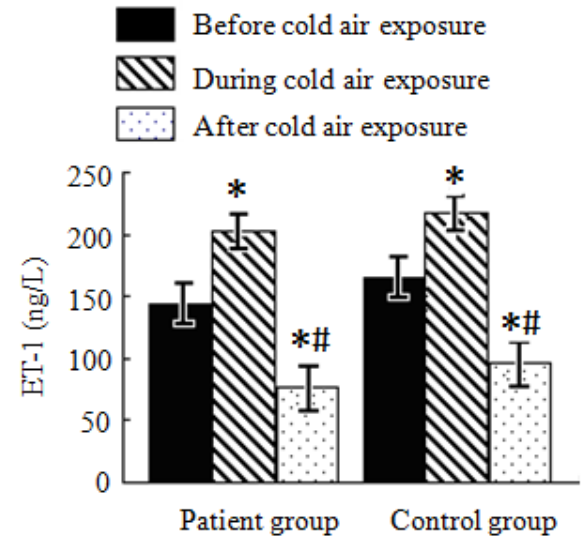
Figure 3. Average ET-1 levels in the patient and control groups during a cold air